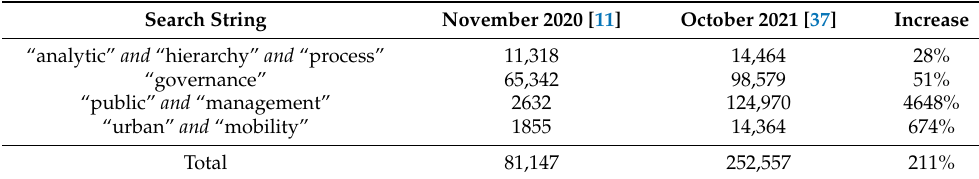
Table 1. Total of documents resulted from searches in Scopus. Search